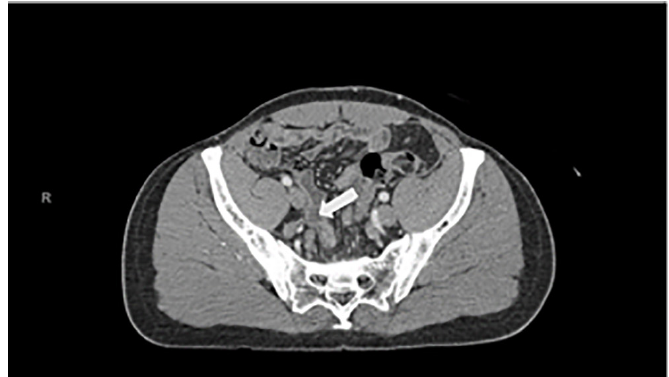
Image 1. Computed tomography abdomen and pelvis with intravenous contrast with the arrow pointing to a normal appendix.